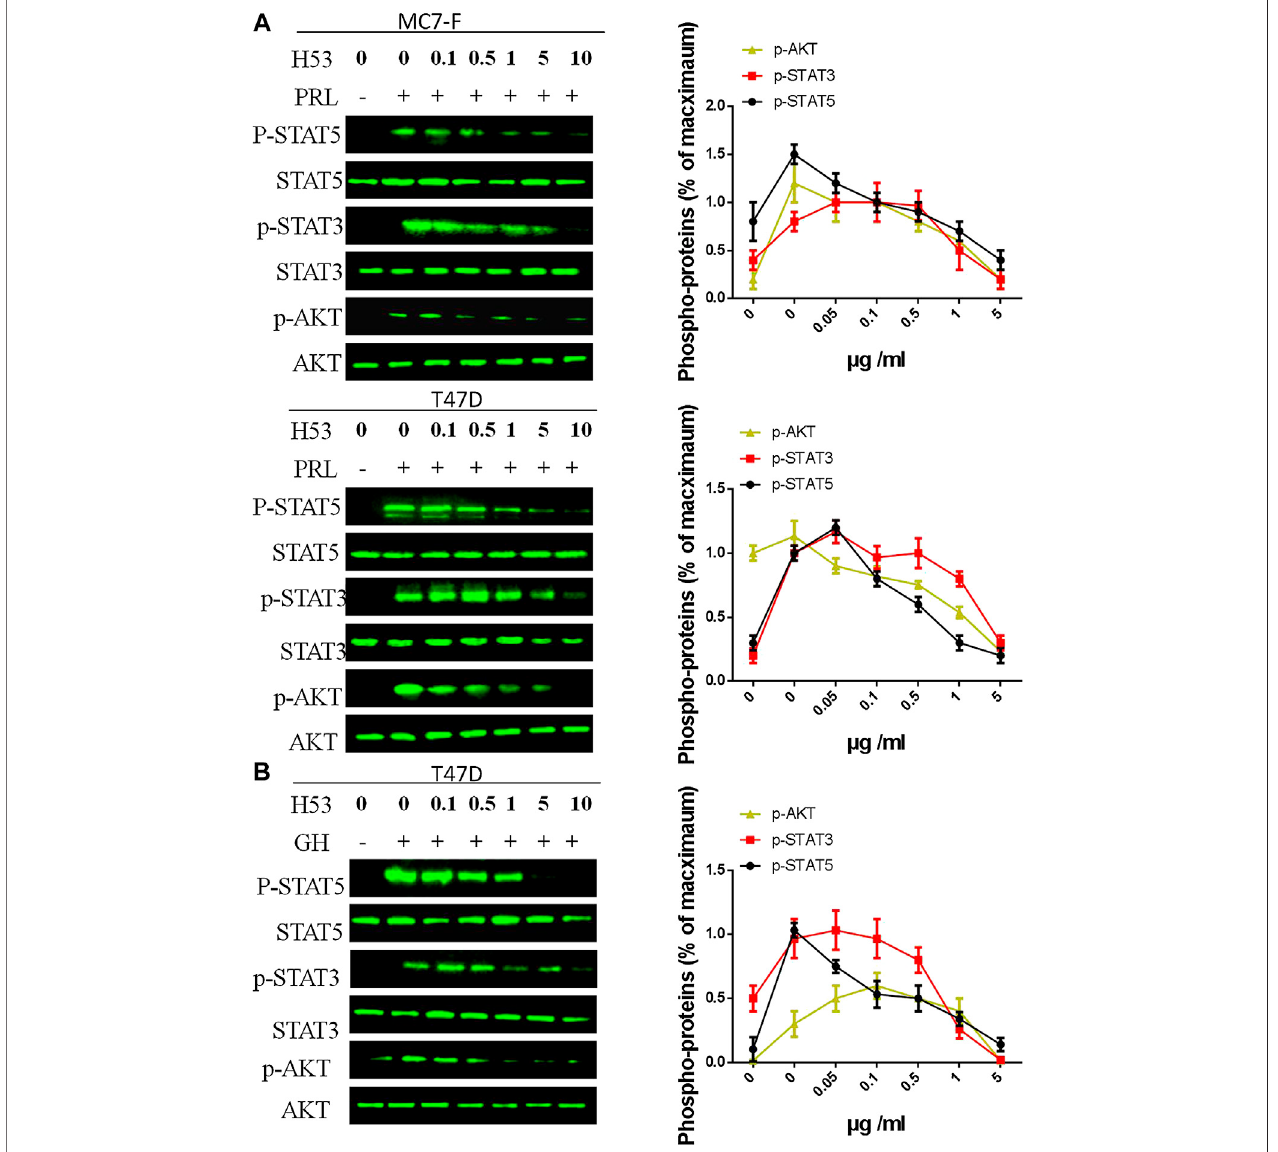
FIGURE 7 | (A,B) Inhibition of PRL-induced signaling pathway by H53. MCF-7 and T47D cells were starved for 12 h. Cells were washed with sterile PBS and treated with PRL alone or mixture containing different concentrations of H53 and constant PRL for the indicated durations. Next, cells were washed and used for western-blot. (C) Inhibition of GH-induced signaling pathway by H53. ImageJ software was used to quantify the optical density of protein bands. Data are presented as the mean ± SD of three independent experiments. The cells were challenged with PRL alone were considered 100%.